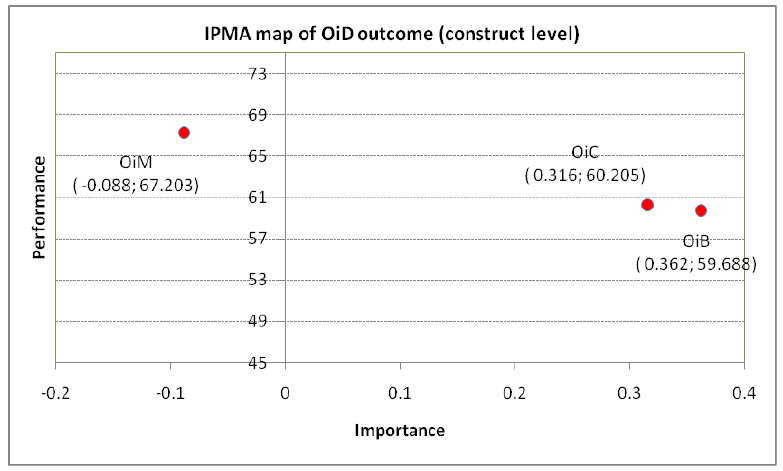
Figure 3. The IPMA map of the target OiA outcome (construct level).